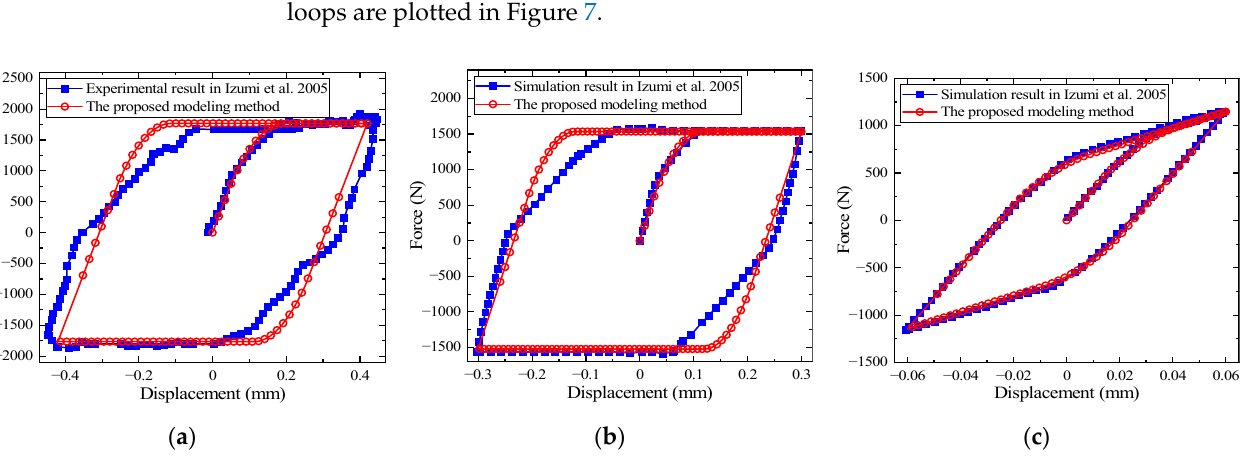
Figure 7. Comparisons between the equivalent modeling method and the results under different transverse displacements: ( a ) comparison of experimental results under 0.3 mm transverse displacement; ( b ) comparison of simulation results with FEM under 0.3 mm transverse displacement; ( c ) comparison of simulation results with FEM under 0.06 mm transverse displacement [48].